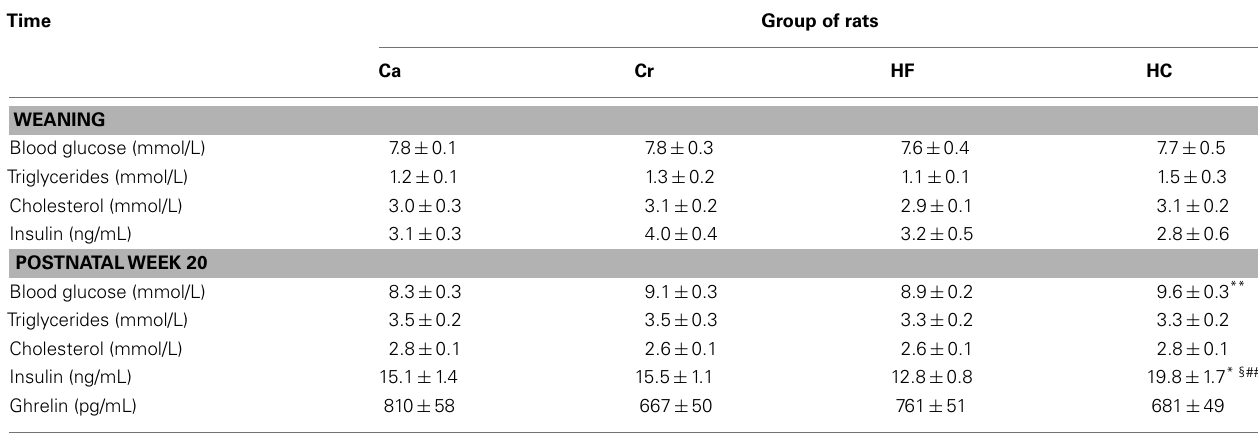
Table 5 | Blood glucose and plasma concentrations of triglycerides, cholesterol, immunoreactive insulin, and ghrelin (mean ± SEM) in offspring from dams fed either a gestational control diet (Ca group) ad libitum , or a restricted control (Cr group), a high-fat (HF group), or a high-carbohydrate (HC group) diet ad libitum for 6h during the light period, in addition to two normal meals given during the dark period.